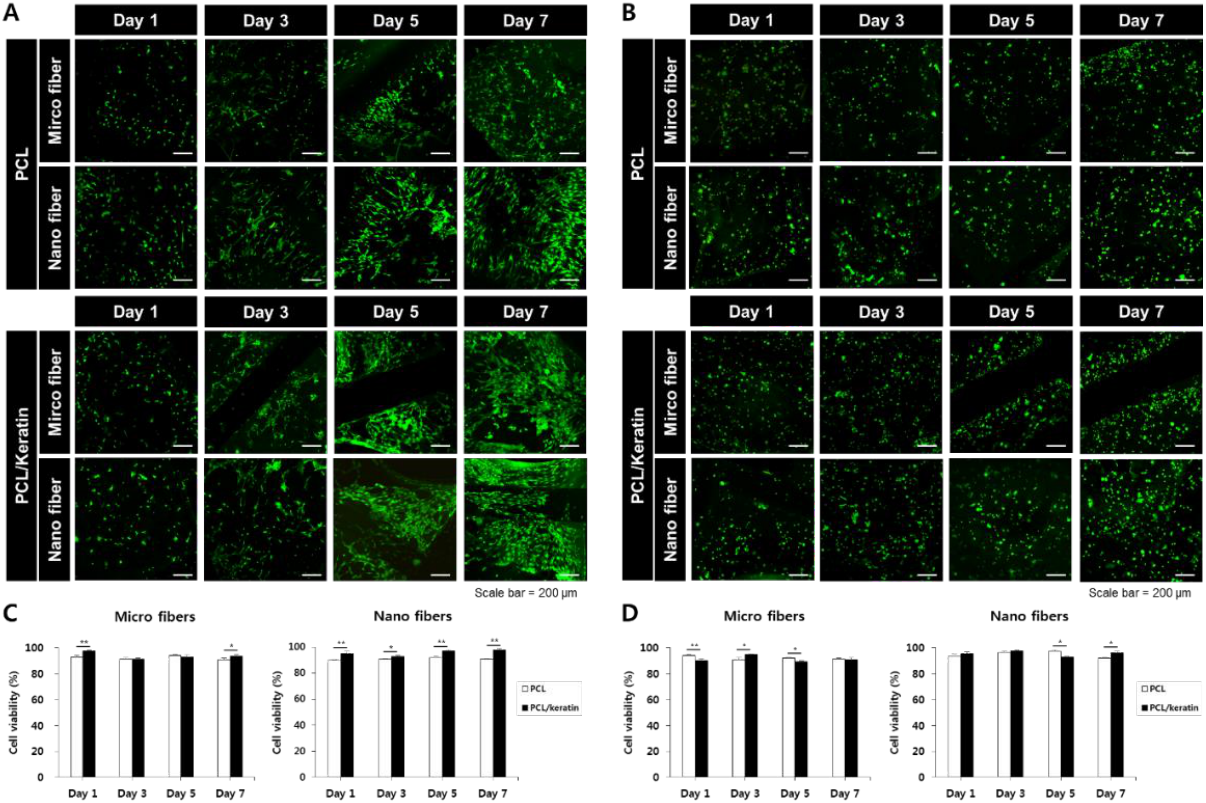
Figure 3. Viability of NHDFs ( A , C ) and HaCaTs ( B , D ) cells cultured on PCL and PCL/keratin electrospun scaffolds, measured via live/dead assay (* p < 0.05, ** p < 0.01, Scale bar = 200 μm).